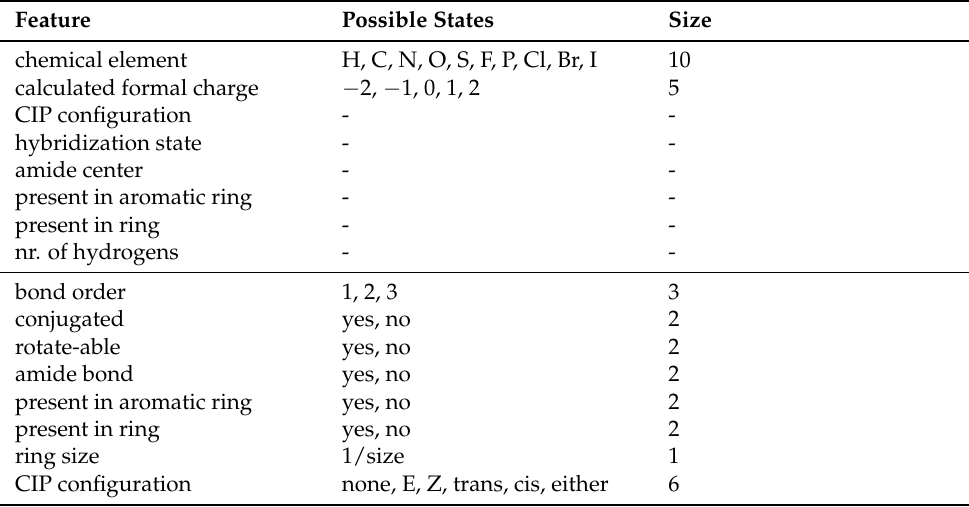
Table A4. Node and edge featurization of type 6. Each node or edge featurization vector consisted of a concatenation of the different one-hot encoded or floating point feature vectors according to their possible states (if present) and corresponding size-15 for nodes and 20 for edges.